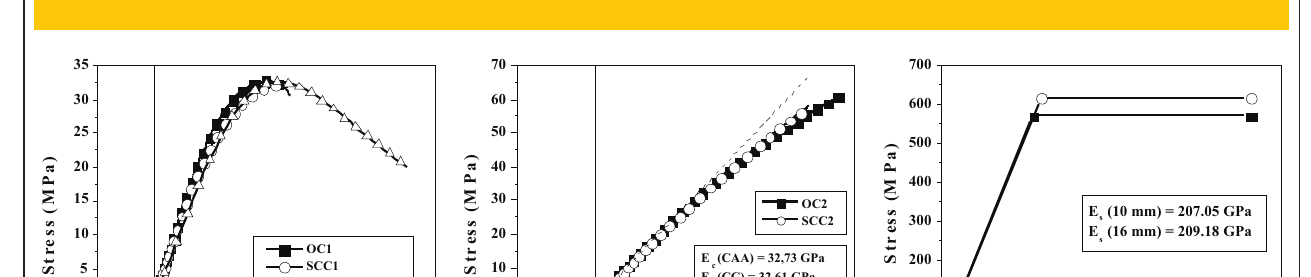
Figure 5 – Stress vs. strain behavior of steel and